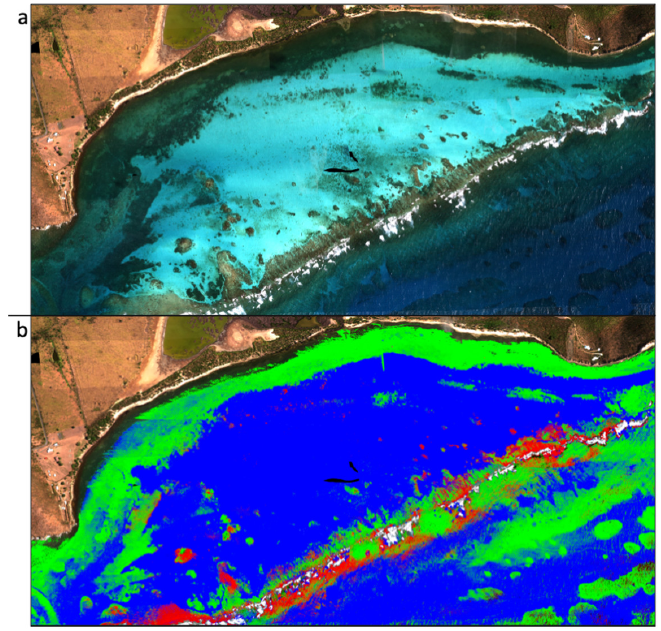
Figure 5. ( a ) True color composite and ( b ) classification of live coral (red) and algae (green) devel- oped from imaging spectroscopy data. Images courtesy of Global Airborne Observatory, Arizona State University.